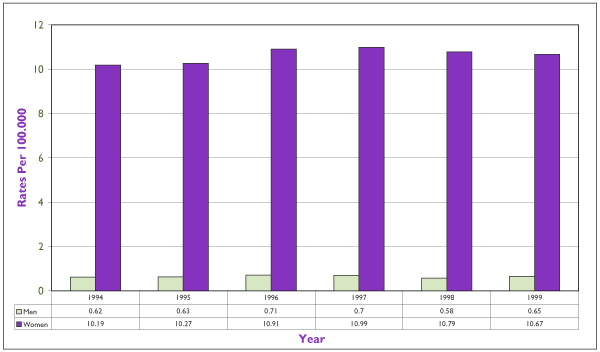
Canadian Inpatient Crude Hospital Separation Rates per 100,000 for Anorexia, Bulimia and Eating Disorder Not Otherwise Specified, 1994–1999 Source: Canadian Institute for Health Information